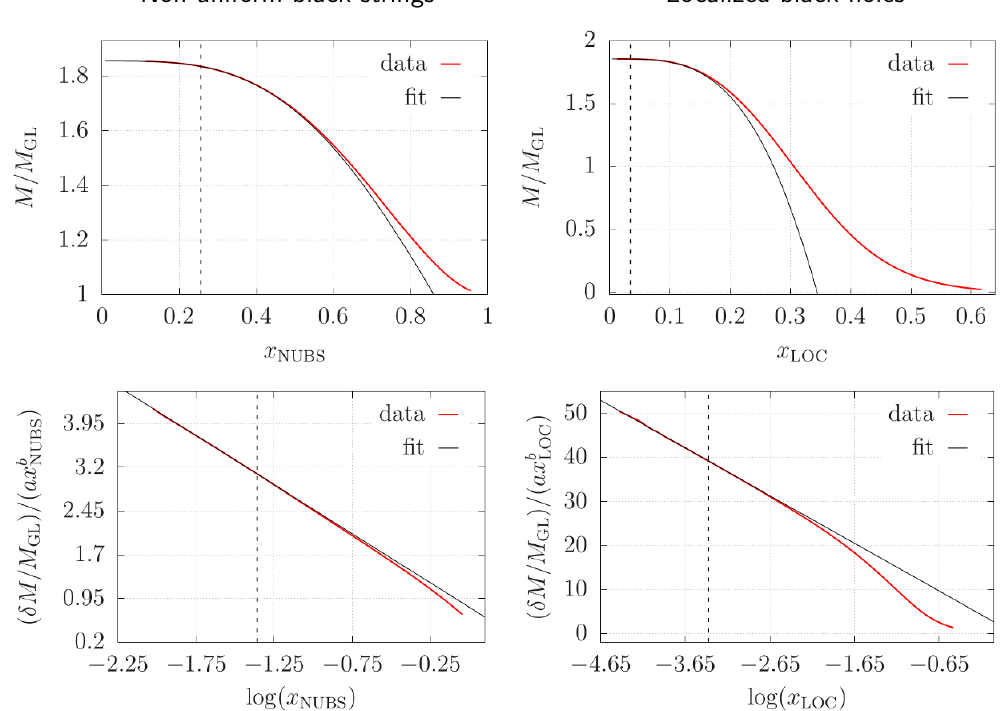
Figure 9 . Normalized mass as a function of x for NUBS and LOC (top row). Data points left to the dashed vertical line are the ones used for the (cid:12)t. In contrast to D = 5 ; 6 cases, in D = 10 our plots do not present any oscillations near the critical point, which agrees with the double-cone prediction of a real critical exponent. At the bottom row we represent (cid:14)M (cid:17) M (cid:0) M c normalized with respect M GL ax b , as a function of log x . The relation is clearly lineal, in agreement with